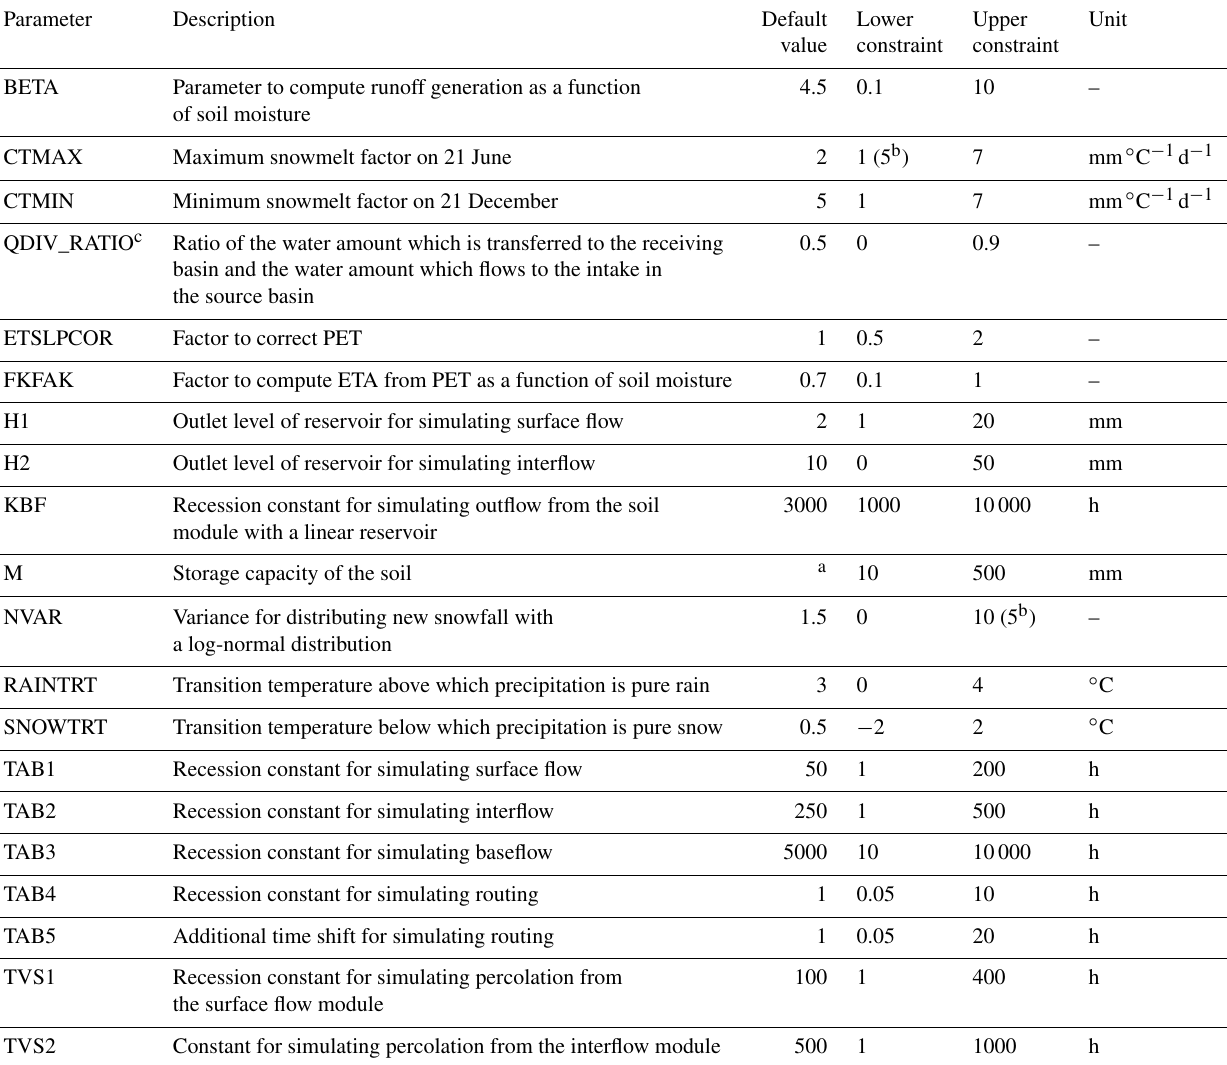
Table C1. Calibrated parameters in the hydrological model